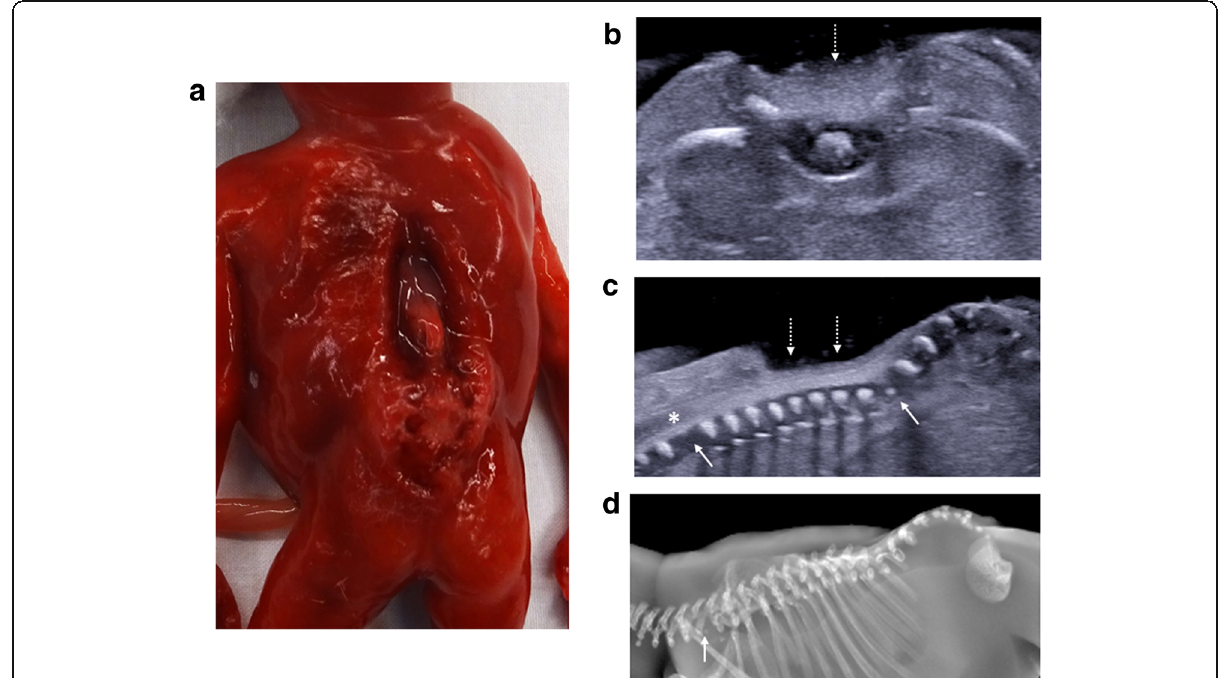
Fig. 2 Neural tube defect following termination of pregnancy in a foetus at 16weeks gestation. On external examination at autopsy ( a ), the large neural tube defect is readily appreciated. The corresponding post-mortem ultrasound images were obtained 4days after death in transverse ( b ) and sagittal ( c ) planes, demonstrating the absence of posterior vertebral elements (dotted arrows), irregular thoracolumbar vertebral ossification (solid arrows) and high conus medullaris of the spinal cord (asterisk). The lateral post-mortem radiograph of the spine ( d ) was able to demonstrate sacral spinal dysraphism and irregular thoracolumbar vertebral ossification (solid arrow), although these findings were better depicted on